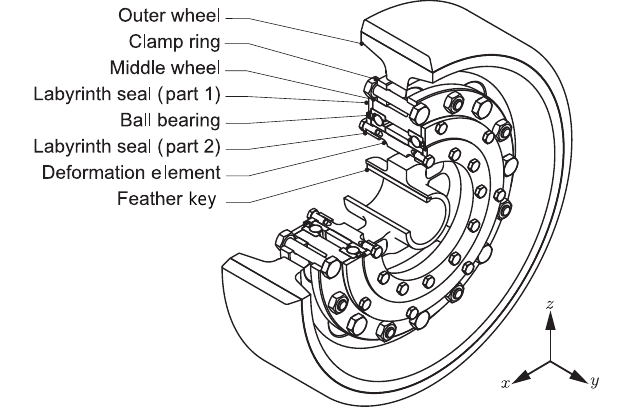
Figure 7. Measurement